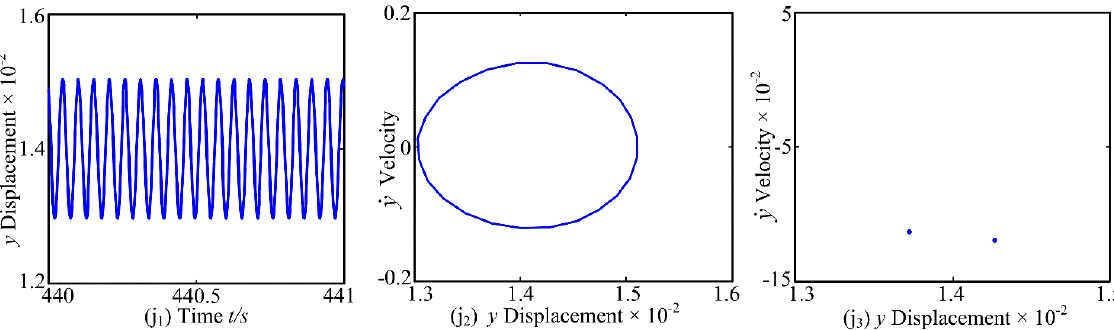
Figure 5. Waveform (1), phase diagram (2) and Poincaré map (3) with ω = 8 chaotic motion ( a ), ω = 21 Periodic-2 motion ( b ), ω = 29.9 quasi-periodic motion ( c ), ω = 35 chaotic motion ( d ), ω = 46.35 Periodic-8 motion ( e ), ω = 47.5 Periodic-4 motion ( f ), ω = 59.5 chaotic motion ( g ), ω = 89.5 quasi-periodic motion ( h ), ω = 110 chaotic motion ( i ) and ω = 119 Periodic-2 motion ( j ).